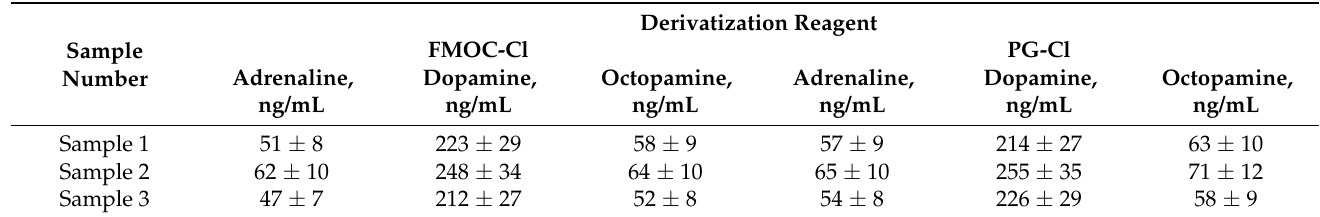
Table 5. Analysis of real urine samples using FMOC-Cl and PG-Cl as derivatization